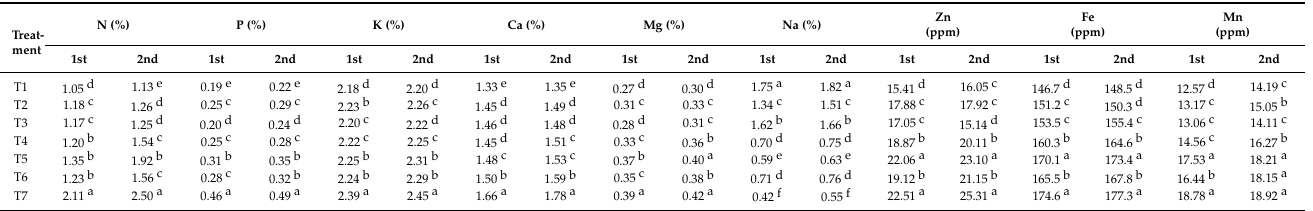
Table 9. Effect of nanoparticle on leaf endogenous nutrients contents of thyme plant during 2020 and 2021 growing